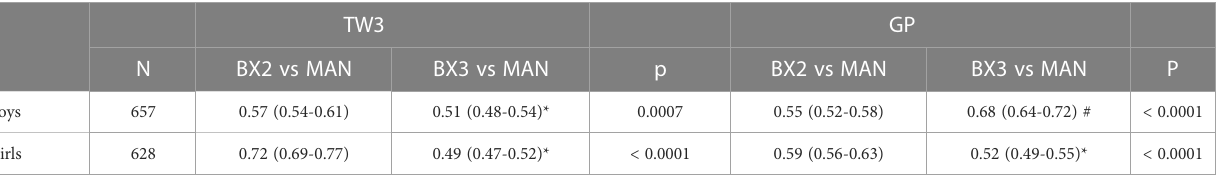
Root mean square errors (and corresponding 95% con fi dence intervals) are shown (in years). p-value: Diebold-Mariano test for method accuracy (* BX3 performs signi fi cantly better than BX2 a = 0.05, # BX3 performs signi fi cantly worse than BX2 at a =0.05). TW3, bone age assessment according to Tanner-Whitehouse 3 method, GP, bone age assessment according to Greulich-Pyle method, BX2, BoneXpert version 2.4.5.1., BX3, BoneXpert version 3.0.3., MAN, manual bone age